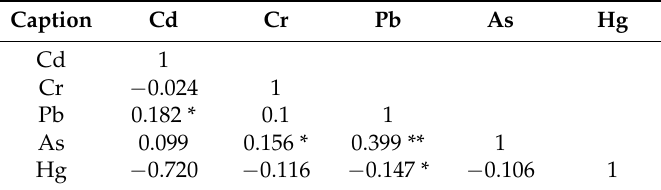
Table 3. Element-to-element correlation coefficients matrix.